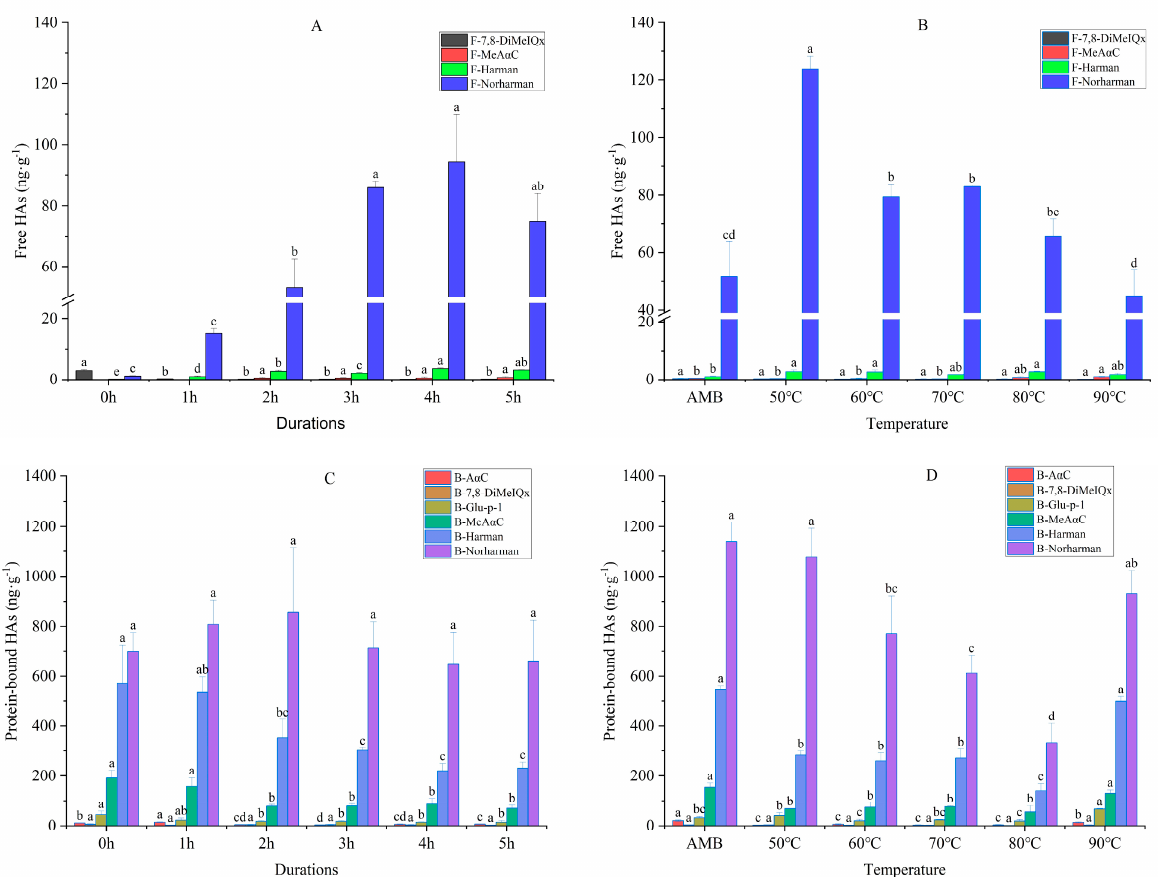
Figure 2. Changes in free HAs ( A , B ) and protein-bound HAs ( C , D ) in smoked meat patties, treated at different smoking durations and temperatures (ng · g − 1 ). Data are presented as means ± standard deviations ( n = 3). AMB represents ambient temperatures. Different letters in each treatment group represent significant differences at p < 0.05.